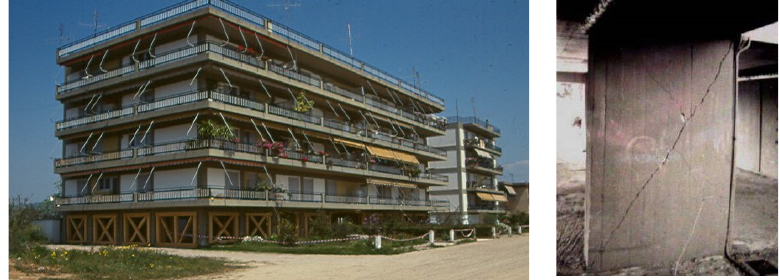
Figure 2. Temporary wooden story. Damaged shear wall at the soft story.